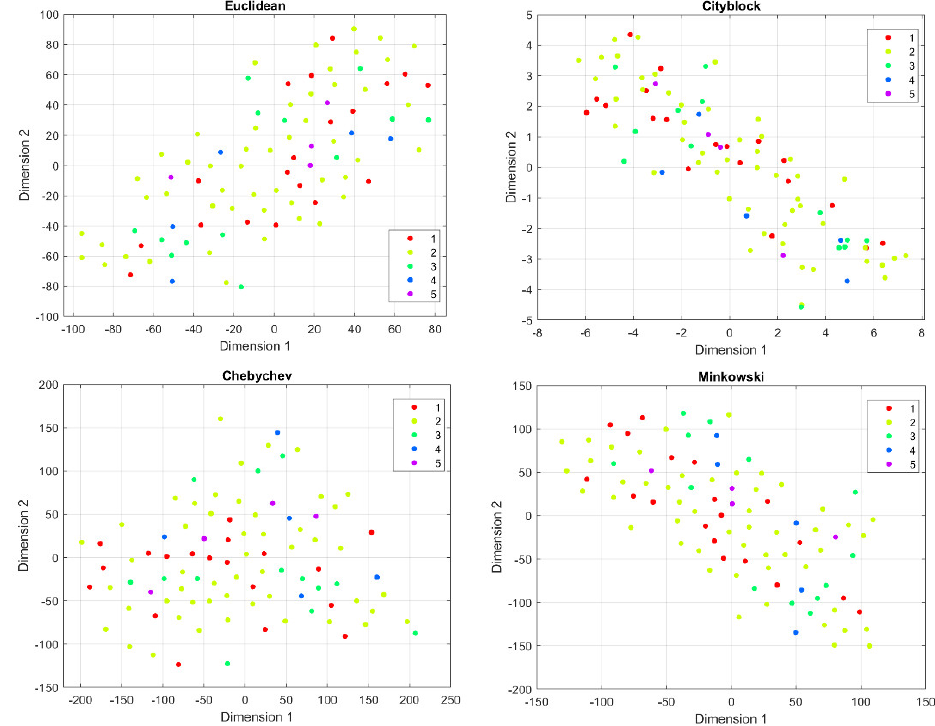
Figure 8. t-SNE results for different distance measurements. ( top left ): Euclidean distance, ( top right ): cityblock distance, ( bottom left ): chebychev distance, ( bottom right ): minkowsi distance.